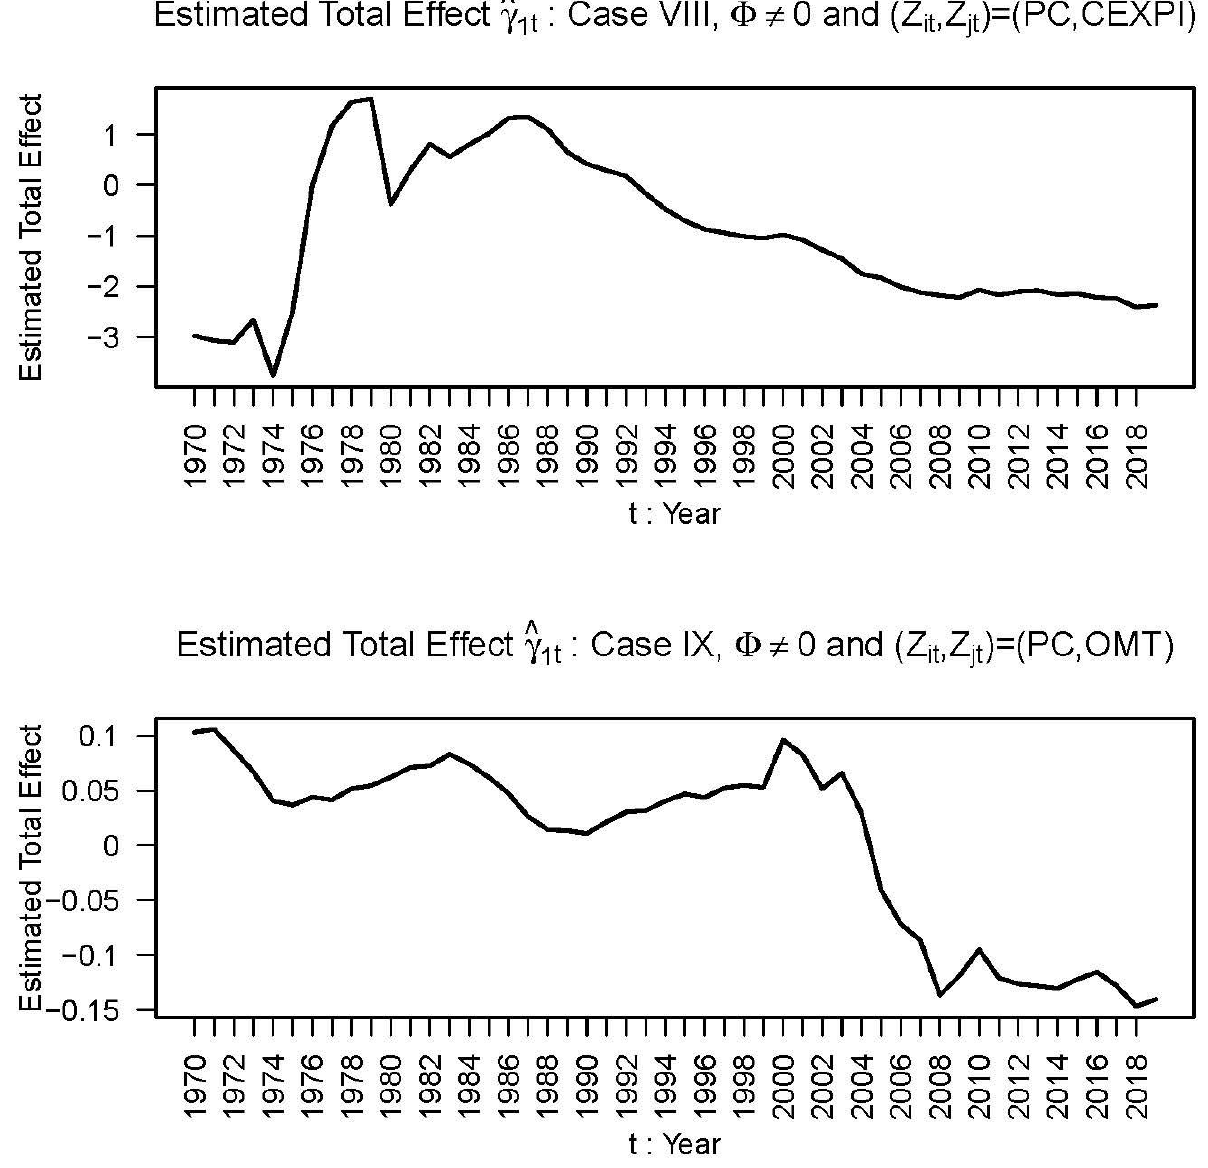
Figure 1. Plot of the estimated total effects of CBC on RGDP in different years.